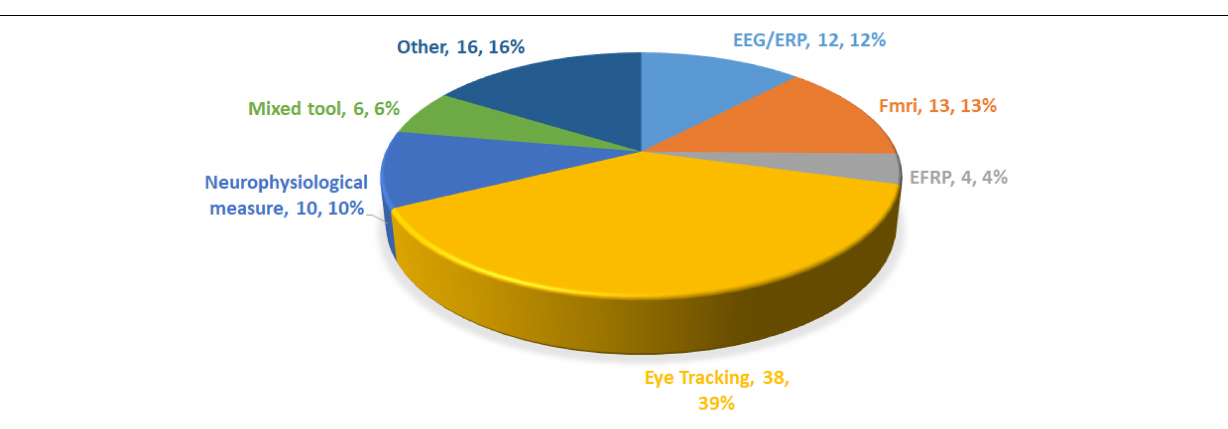
FIGURE 5 | Analysis of neuroscience tools from 2010 to